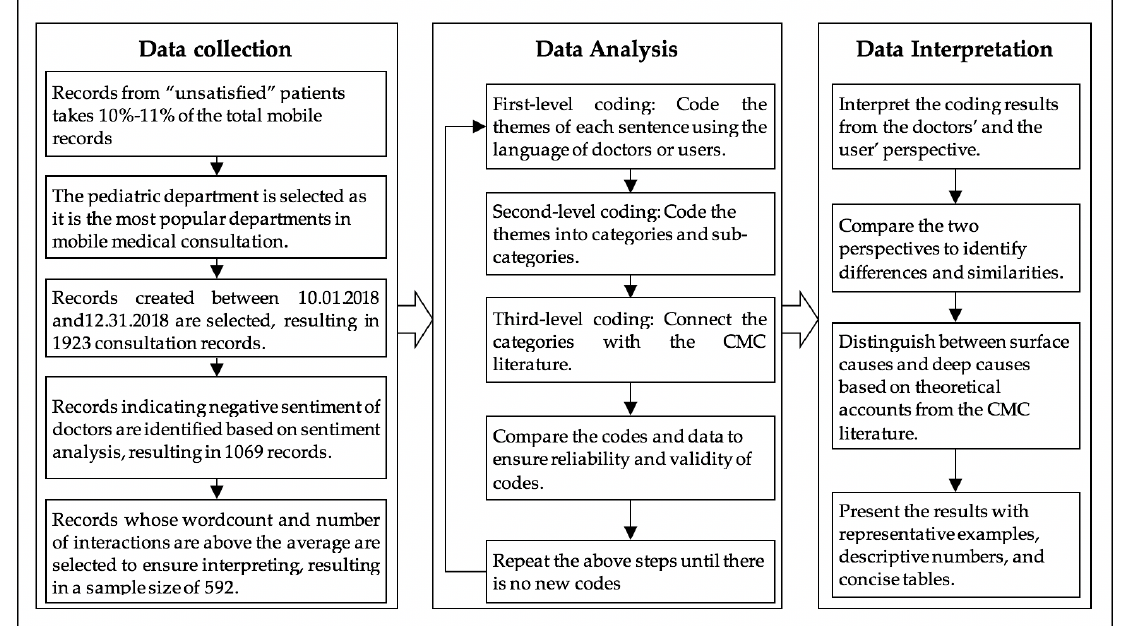
Figure 2. The methodology roadmap.